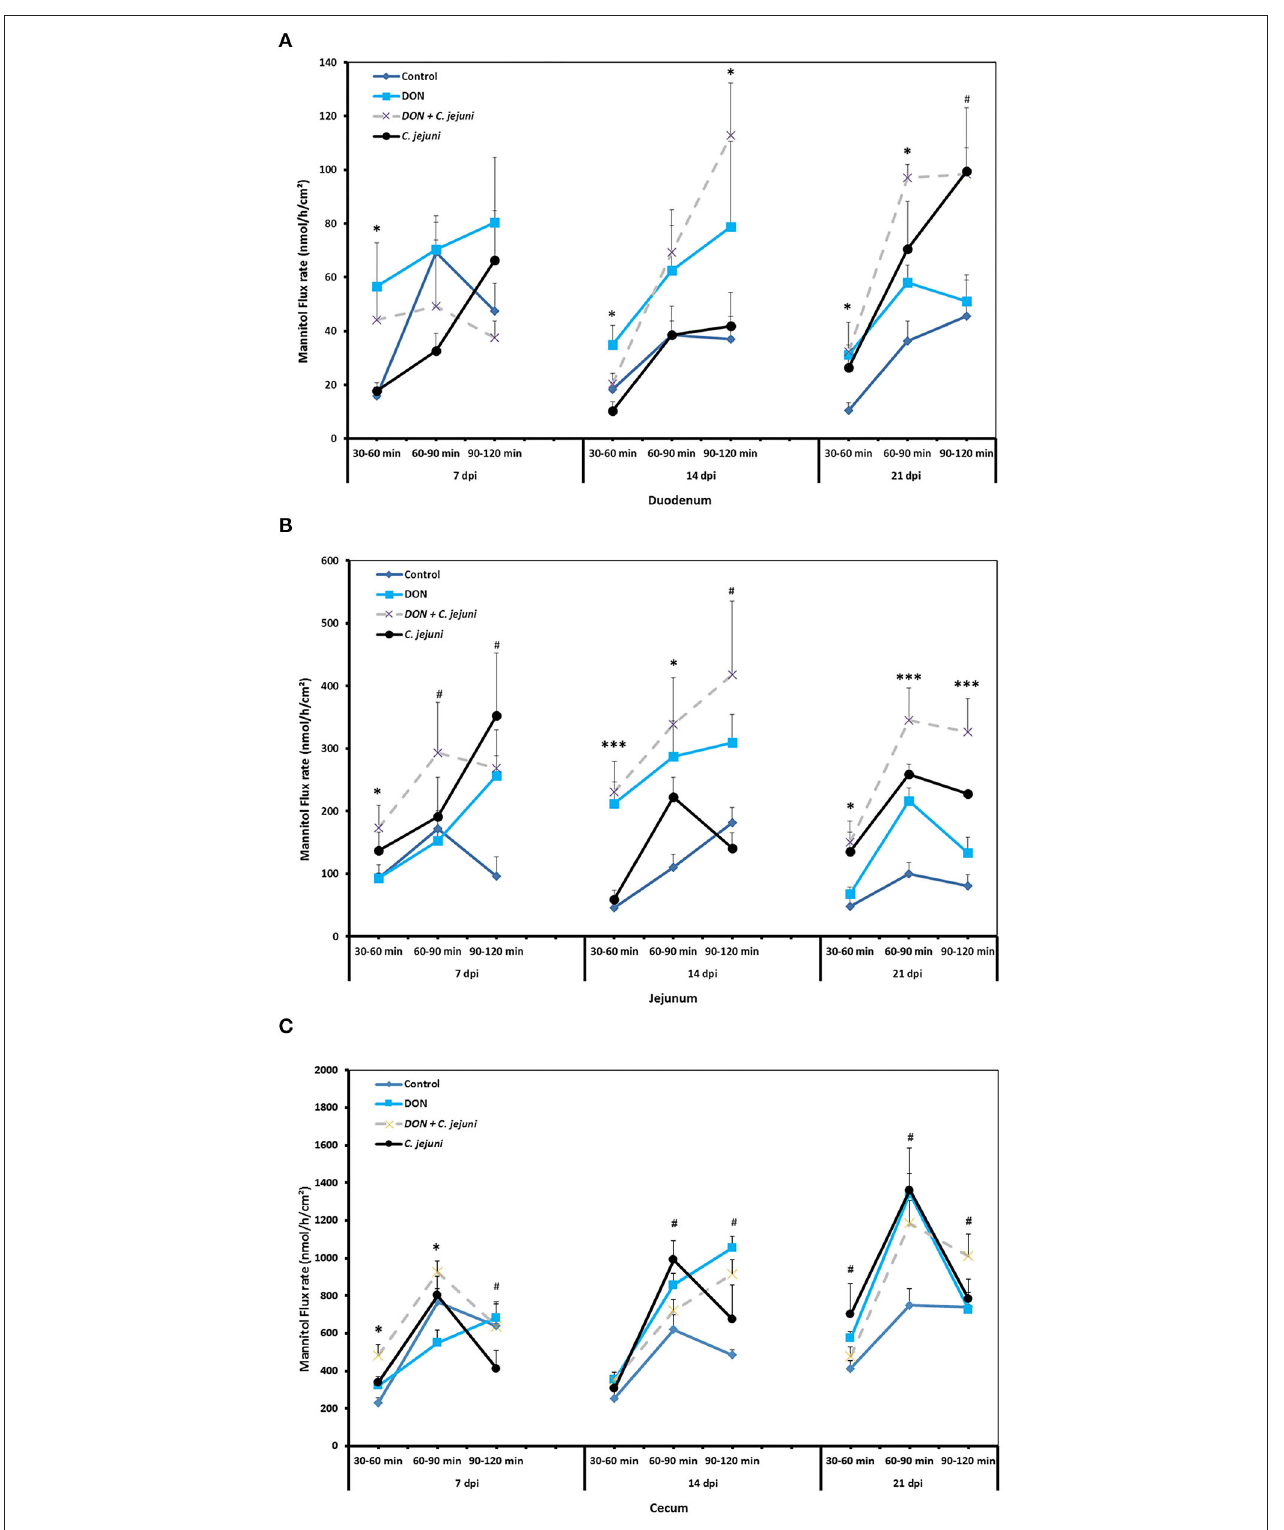
FIGURE 3 | Effect of DON and/or C. jejuni exposure on paracellular permeability in duodenum (A) , jejunum (B) , and cecum (C) at different times post infection. Mucosal to serosal flux (J ms ) of the permeability marker 14 C-mannitol were performed in Ussing chambers. Data are presented as the mean values and SEM ( n = 5). Asterisks mark differences with # P ≤ 0.1, * P ≤ 0.05, or *** P ≤